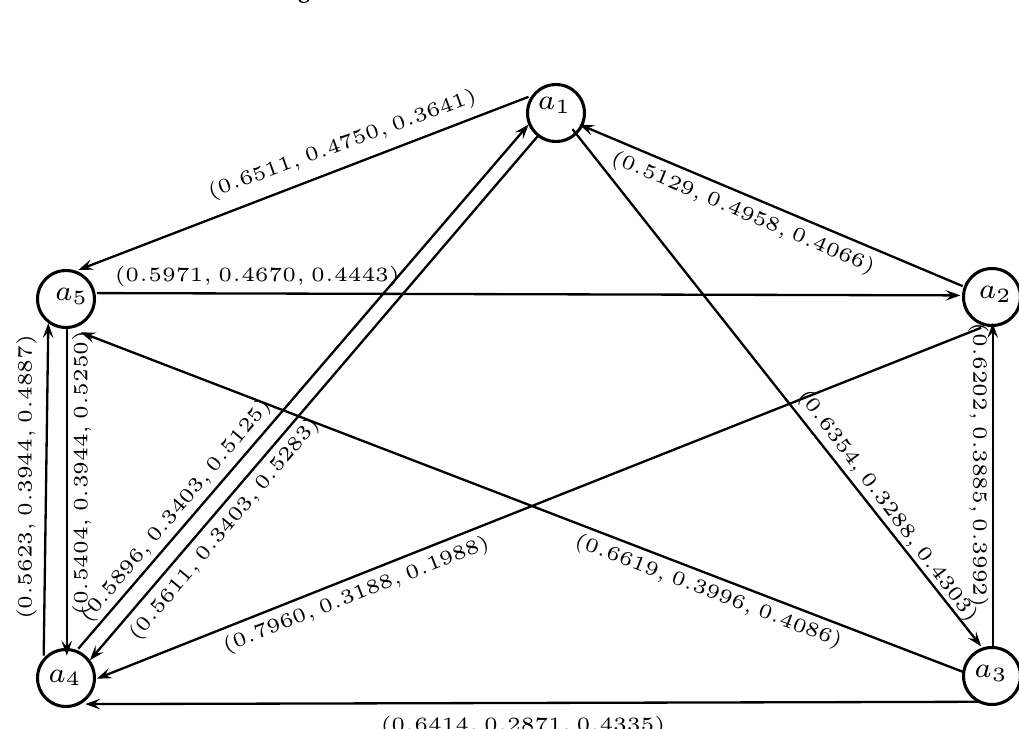
Figure 19. Directed model of the combined SFPR. Figure 19: Directed model of the combined SFPR